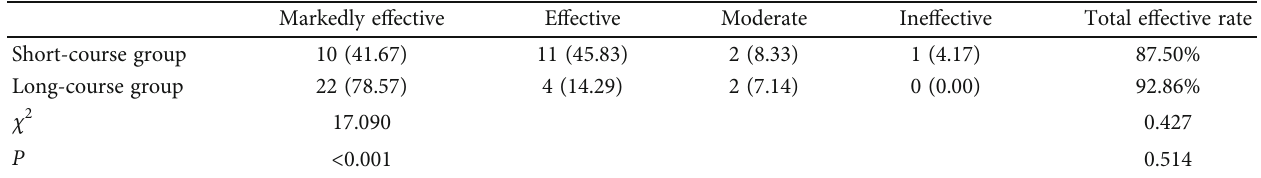
Figure 7: Comparison of recurrence rates. Table 6: Comparison of clinical e ffi cacy between the short-course group and the long-course